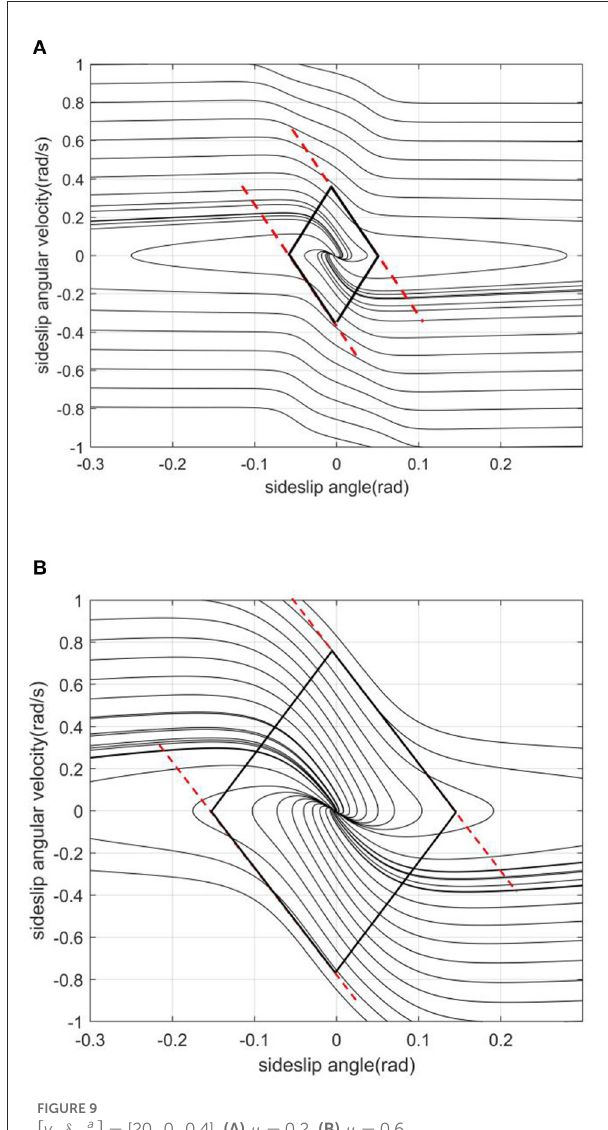
v , δ , a = [20, 0, 0.4]. (A) µ = 0.2. (B) µ = L (cid:3) (cid:2)